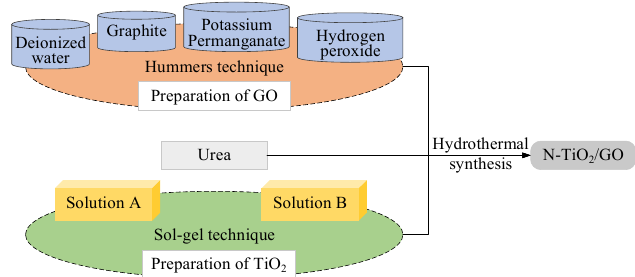
Figure 1. The process to prepare GO composite.